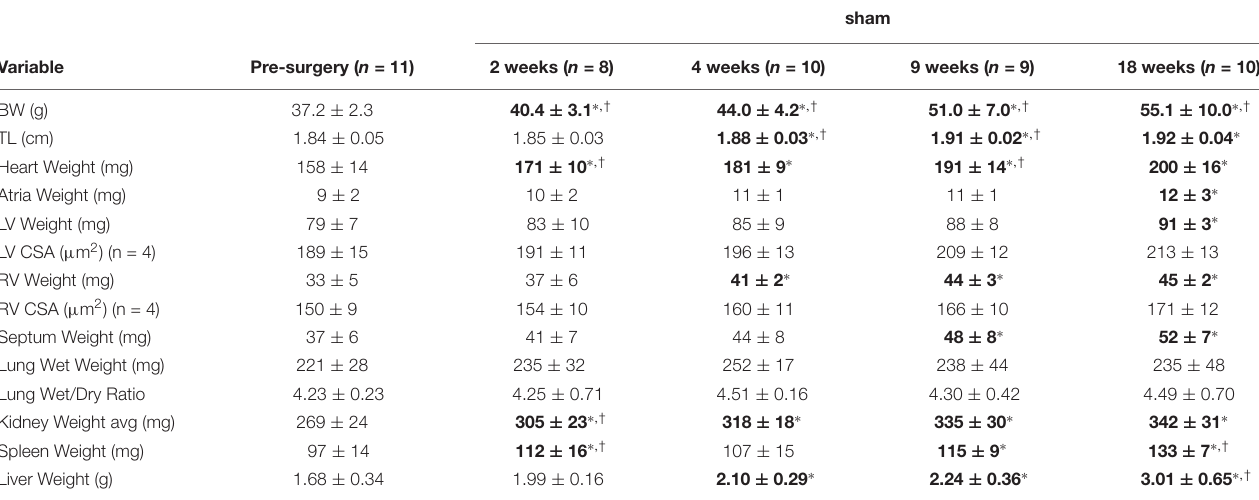
TABLE 4 | Morphometric characteristics of sham